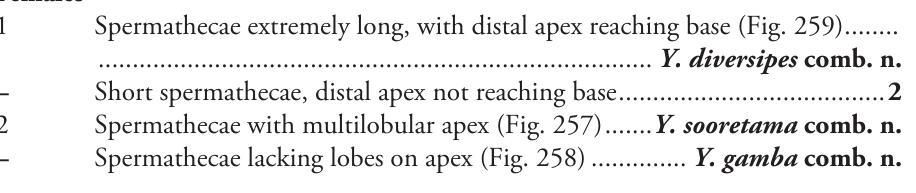
Diagnosis (amended from Bertani and Fukushima 2009) . Females of Y. sooretama comb. n. resemble those of Y. gamba comb. n. by elongated spermathecae with accentu- ated outwards curvature medially and by retaining vestiges of characteristic juvenile color pattern on abdomen. They differ from those of Y. gamba comb. n. by spermathecae bear- ing multilobular apex (Fig. 257). Males resemble those of Y. gamba comb. n. by embolus length 3.0 to 3.5 times tegulum’s length and lacking a very strong curvature in frontal view (Fig. 262). They differ from those of Y . gamba comb. n. by developed prominence on tegulum (Fig. 262) and by central longitudinal black stripe on dorsal abdomen. Description, color pattern ontogeny, distribution and natural history. See Bertani and Fukushima (2009) (Fig. 256). Complementary description. Male: Palp (Figs 260–263): globous bulb with small subtegulum and developed prominence on tegulum. Embolus: not flattened, lacking keels, 3.15 long in retrolateral view, about 3.5 times tegulum’s length. Medial portion and tegulum’s margin form an obtuse angle in retrolateral view. Proximal part very curved in frontal view; thin distal width, abruptly narrowing distally; basal, middle, and distal width of 0.63, 0.13, 0.03, respectively. Tegulum: 1.61 long, 0.94 high. Cymbium subtriangular with subequal lobes, lacking process on retrolateral lobe (Fig. 264). Tibial apophysis in leg I absent (Figs 265–267).